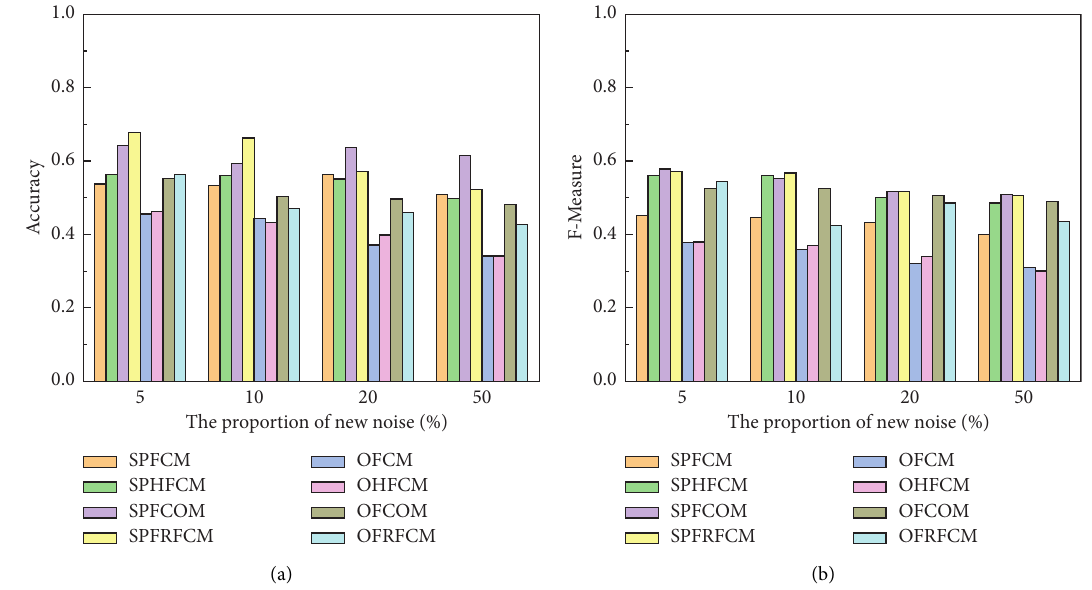
Figure 7: Robustness comparison on the SE dataset. (a) Accuracy; (b) F-Measure.